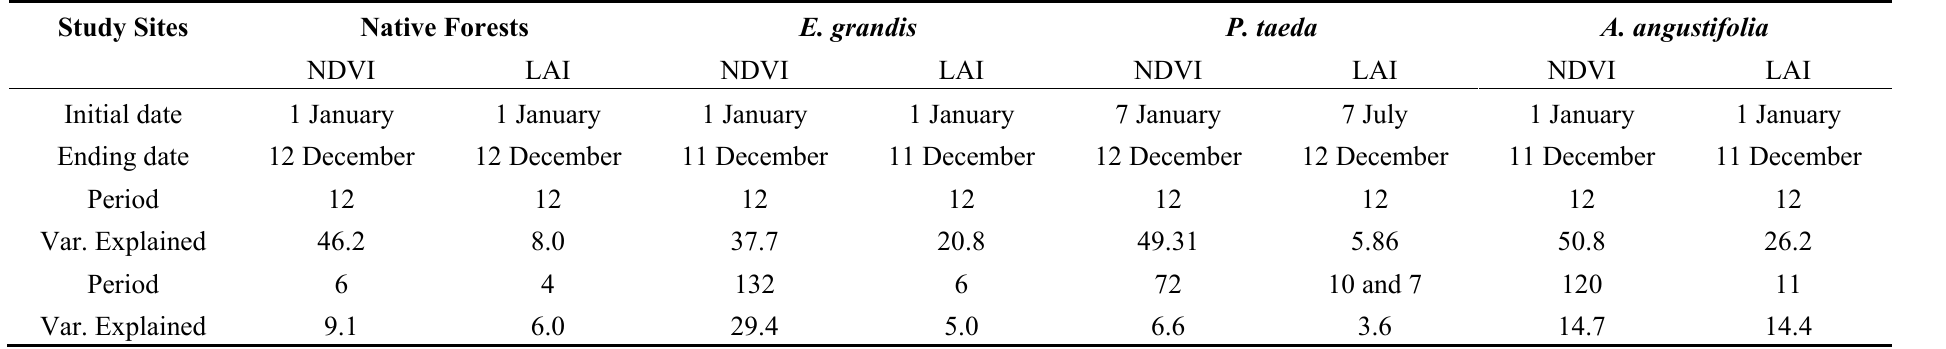
Table 4. Parameters of the time series analysis of the NDVI (Normalized Difference Vegetation Index) and LAI (Leaf Area Index) values obtained from remote sensing for native forest stands and Eucalyptus grandis , Pinus taeda and Araucaria angustifolia tree plantations. The period (in months) is the length of the recurring time cycles that explained the two largest amount of variance (Var. explained) in the time series. The initial and ending dates of the time series are also